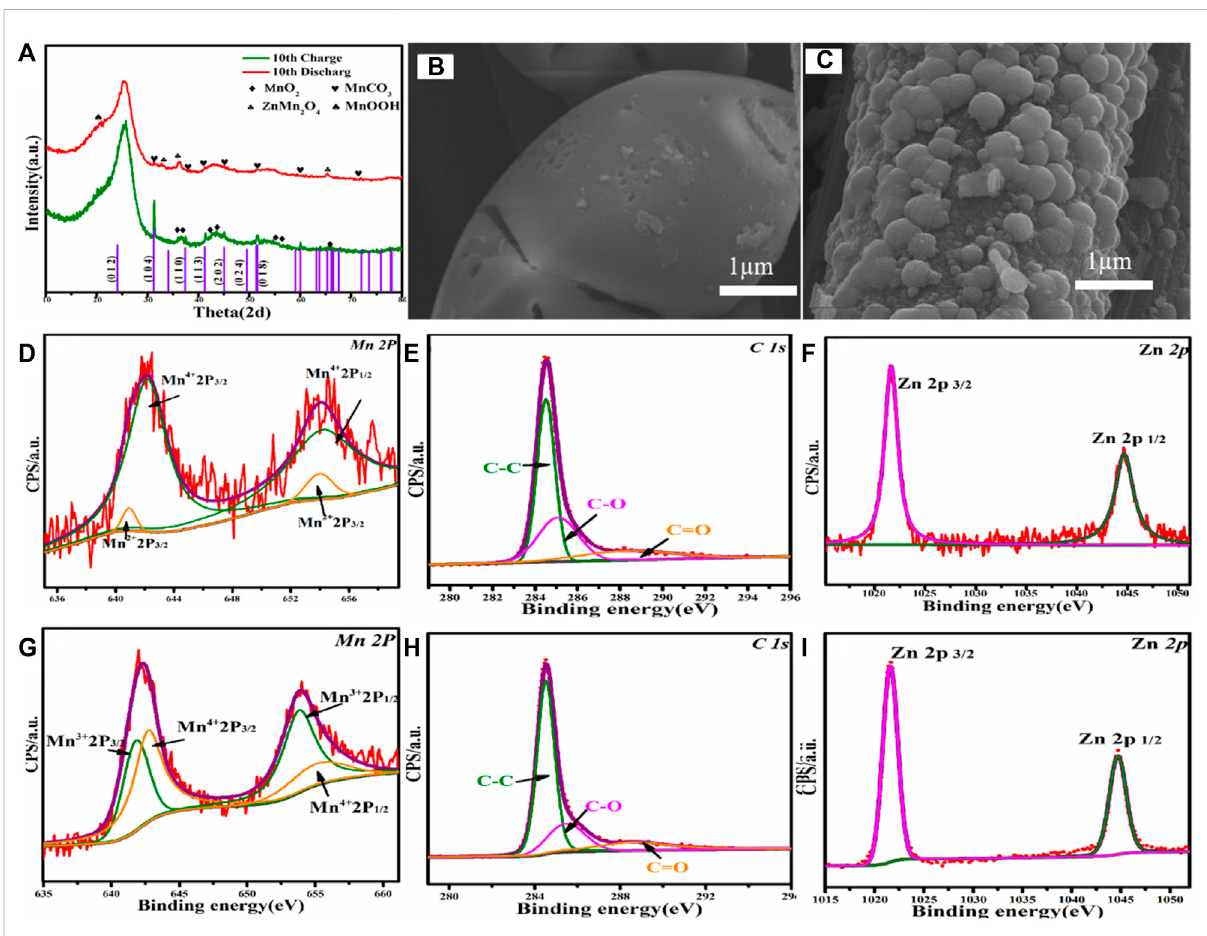
FIGURE 5 (A) The XRD pattern of MnCO 3 @CC in charge to 2.0 V and discharge to 0.3 V at 0.1 A g − 1 after 10 cycles. (B) The SEM image of MnCO 3 @CC under charge to 2.0 V at 0.1 A g − 1 after 10 cycles. (C) The SEM image of MnCO 3 @CC under discharge to 0.3 V at 0.1 A g − 1 after 10 cycles. (D – F) The XPS patterns of MnCO 3 @CC for Mn, C, and Zn elements under charge to 2.0 V at 0.1 A g − 1 after 10 cycles. (G – I) The XPS patterns of MnCO 3 @CC for Mn, C, and Zn elements under discharge to 0.3 V at 0.1 A g − 1 after 10